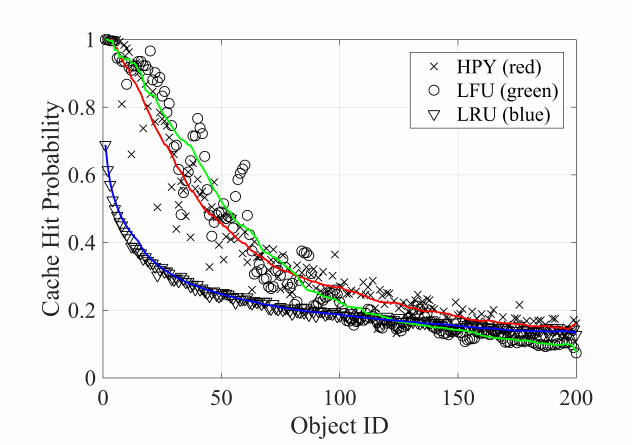
Figure 16. Cache hit probability for the 200 most popular items for a cache on the network